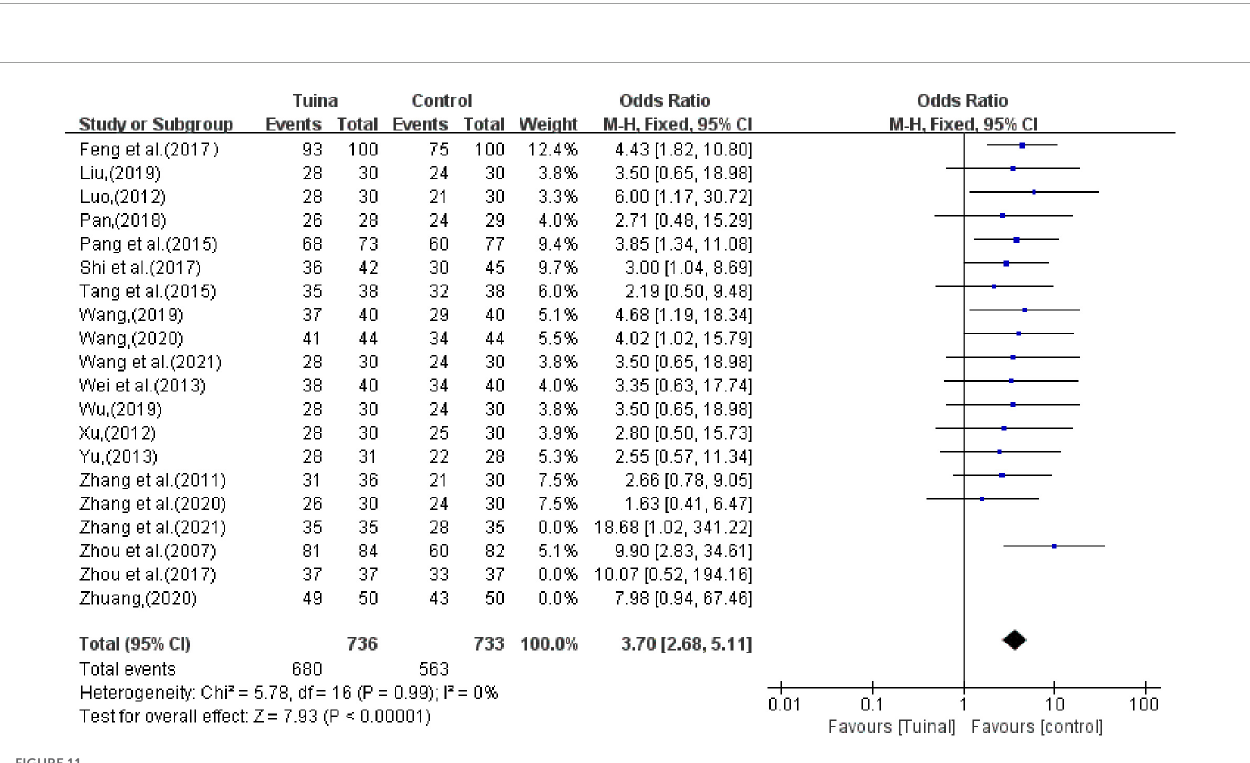
FIGURE11 Forest plot of tuina for objective response rate (ORR) after sensitivity analysis.